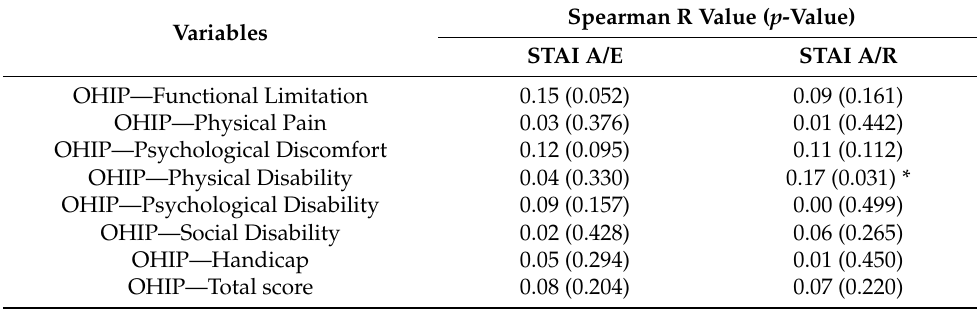
Table 5. Associative analysis between OHIP-14 and STAI variables ( n = 120).